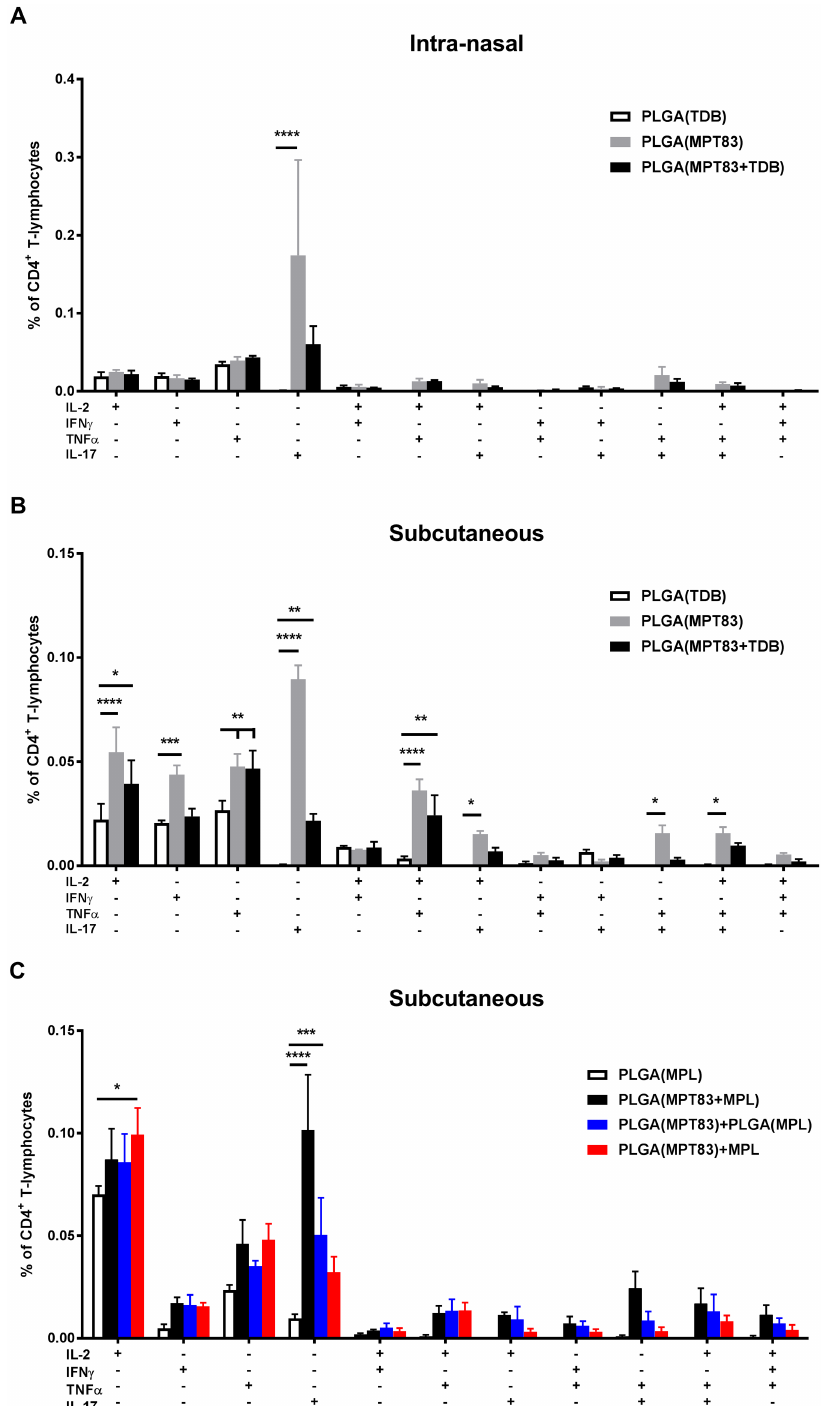
Fig 3. PLGA vaccination induces systemic antigen-specific cytokine responses. Frequency of cytokine-producing CD4 + T-lymphocytes in the spleens of mice immunised (A) i.n and (B) s.c with TDB adjuvanted vaccines, and (C) s.c with MPL adjuvanted vaccines, as assessed at four weeks following final immunisation. Antigen-specific cells were detected by intra-cellular immunostaining and flow cytometry after recall with MPT83 (10 μg/ml) for 12 hr followed by addition of Brefeldin A and further incubation for 4 hr. Data are the means ± SEM (n = 3) and are representative of two independent experiments. Statistically significant differences were determined by ANOVA with post-hoc Bonferroni comparison to adjuvant only control ( (cid:3) p < 0.05, (cid:3)(cid:3) p < 0.01, (cid:3)(cid:3)(cid:3) p < 0.001, (cid:3)(cid:3)(cid:3)(cid:3) p < 0.0001).